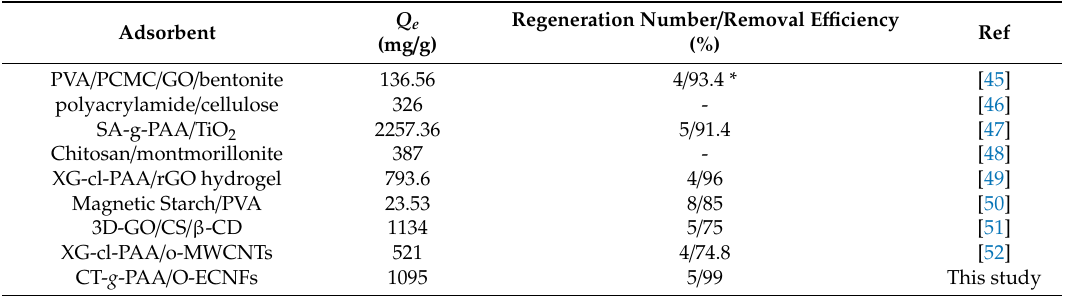
Table 4. Comparison of adsorption capacity and reusability of CT- g -PAA-O-ECNFs for MB dye removal with other hydrogel